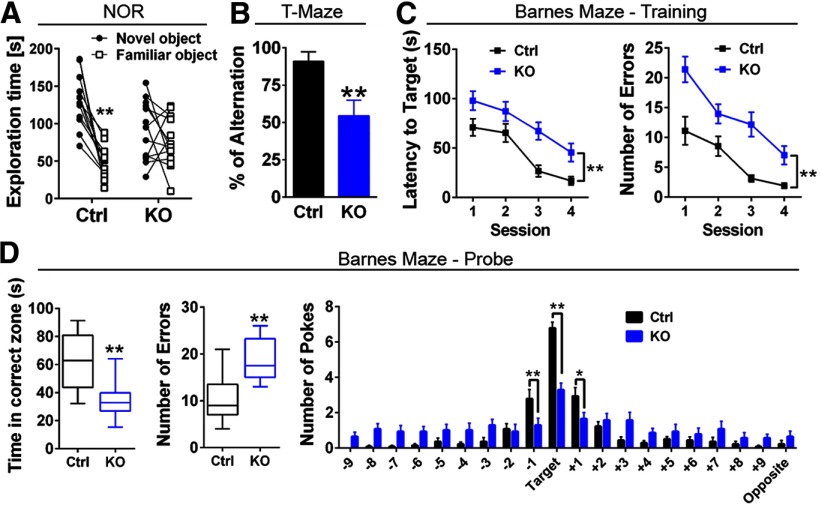
ErbB4 KO mice exhibit spatial learning and memory deficits. A, ErbB4 KO mice (n = 13) show deficits during the NOR test as compared with control mice (Ctrl, n = 13). ErbB4 KO mice were impaired to differentiate between the novel versus familiar object, assessed by the total time each object was explored during the probe session. B, In contrast to control mice (Ctrl, black, n = 11), ErbB4 KO mice (KO, blue, n = 11) had lower spontaneous alternation in the T-maze. C, Barnes maze (n = 14/genotype) revealed learning deficits in ErbB4 KO mice to locate the target during the training sessions (days 1–4), including higher latency time to find the target (left panel) and more errors (right panel). D, Consistently, the probe session (day 5) indicated that ErbB4 KO mice were impaired to locate the target, as the time spent in the correct zone was reduced (left panel), the number of incorrect nose pokes (errors) were higher (middle panel), and the number of nose pokes in the target and holes +1 and −1 were significantly lower than controls (right panel); *p < 0.05, **p < 0.01.